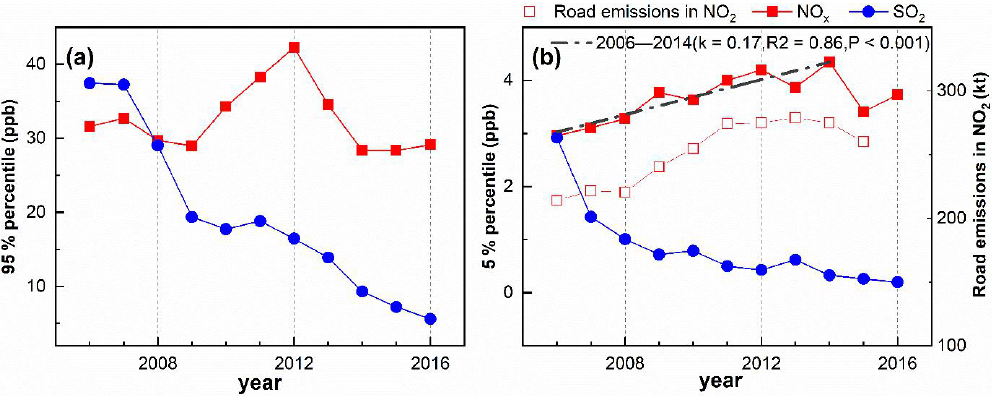
Figure 9. Annual variations in the 95th percentile concentration (a) and the 5th percentile concentration (b) of NO x and SO 2 at LAN; data of NO 2 road emissions in the YRD are obtained from the REASv3.2 data sets in the Regional Emission Inventory in Asia (Kurokawa and Ohara, 2020).